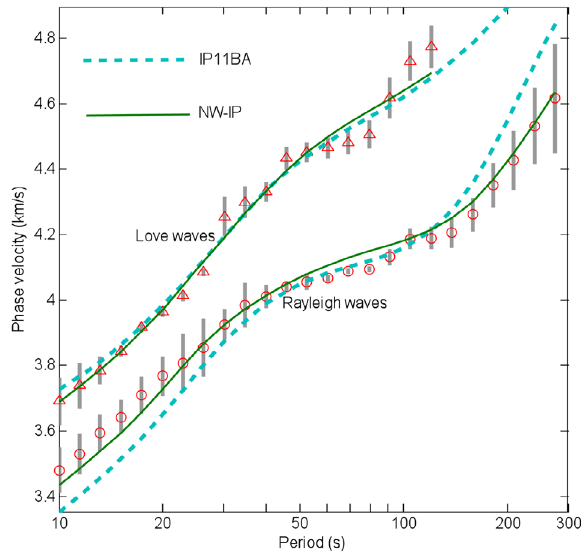
Table 4. Mean ( c ) and standard deviation ( sd ) of observed Rayleigh and Love wave phase